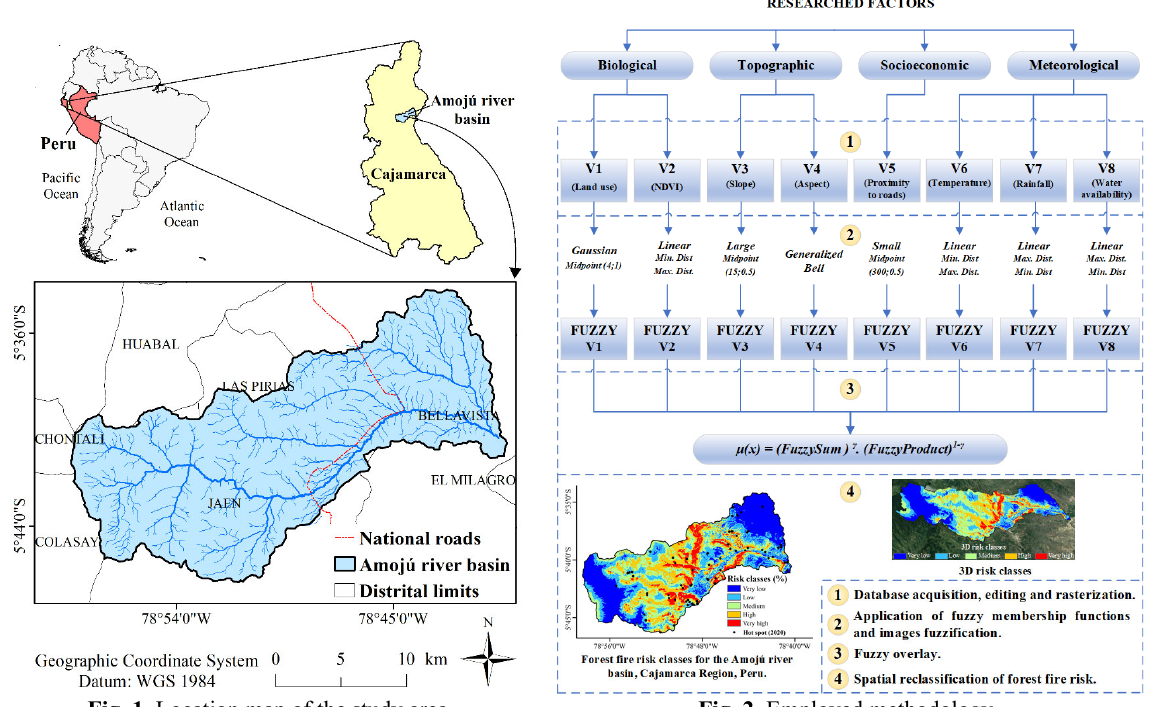
Fig. 1 . Location map of the study area Fig. 2. Employed